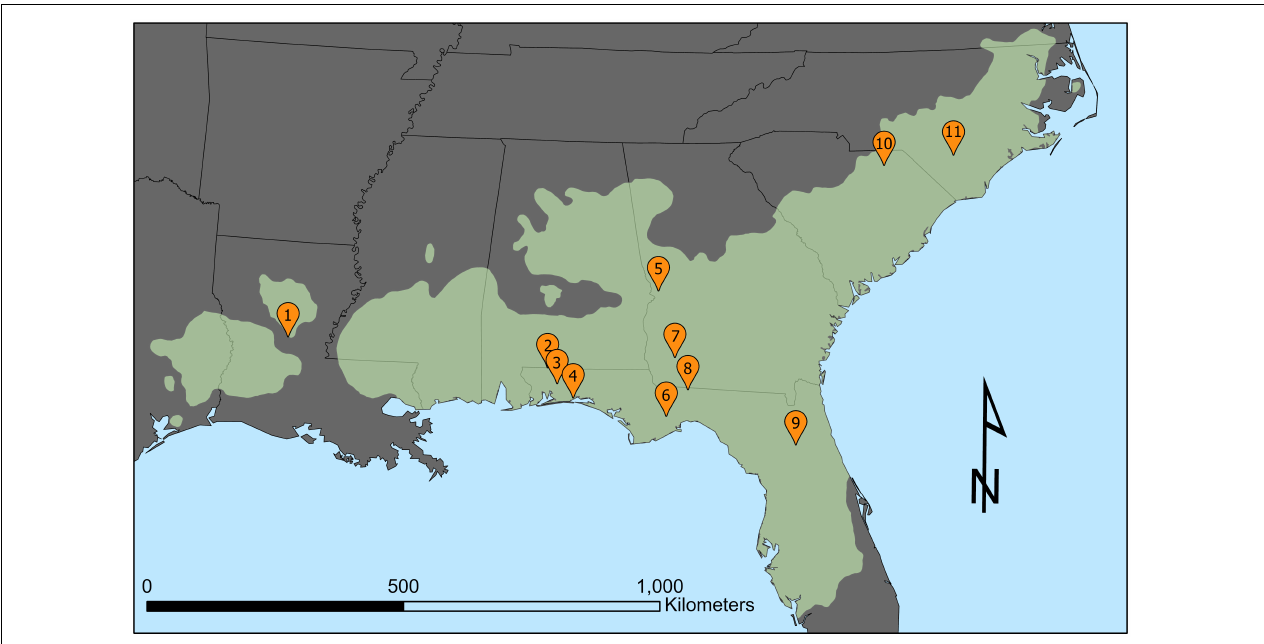
FIGURE 1 | Map of the 11 USFS cone-count locations (orange pins) within the longleaf pine range (light green). Cone count locations are ordered west to east as follows: 1. Kisatchie National Forest, Grant Parish, Louisiana; 2. T. R. Miller Woodlands (Escambia Experimental Forest), Escambia County, Alabama; 3. Blackwater